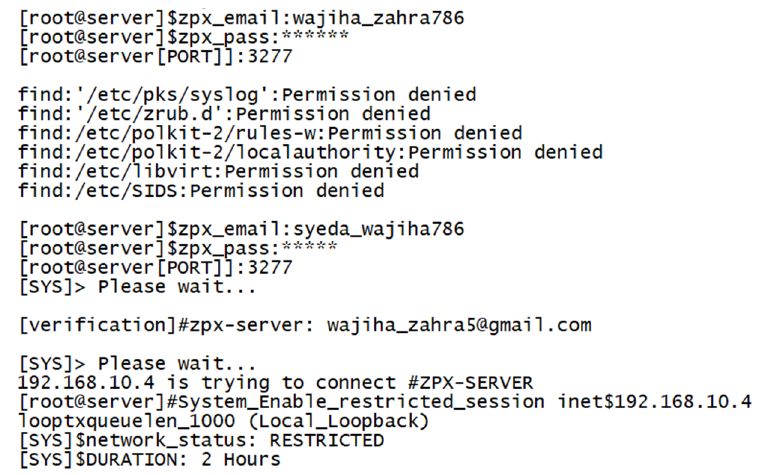
Figure 5. Temporary IP address blocking.